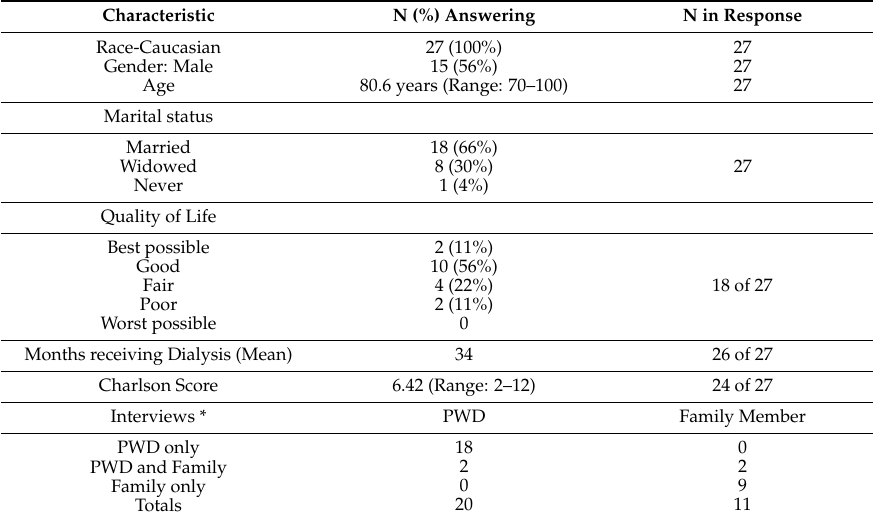
Table 1. Demographics of people living with dialysis (PWD) in